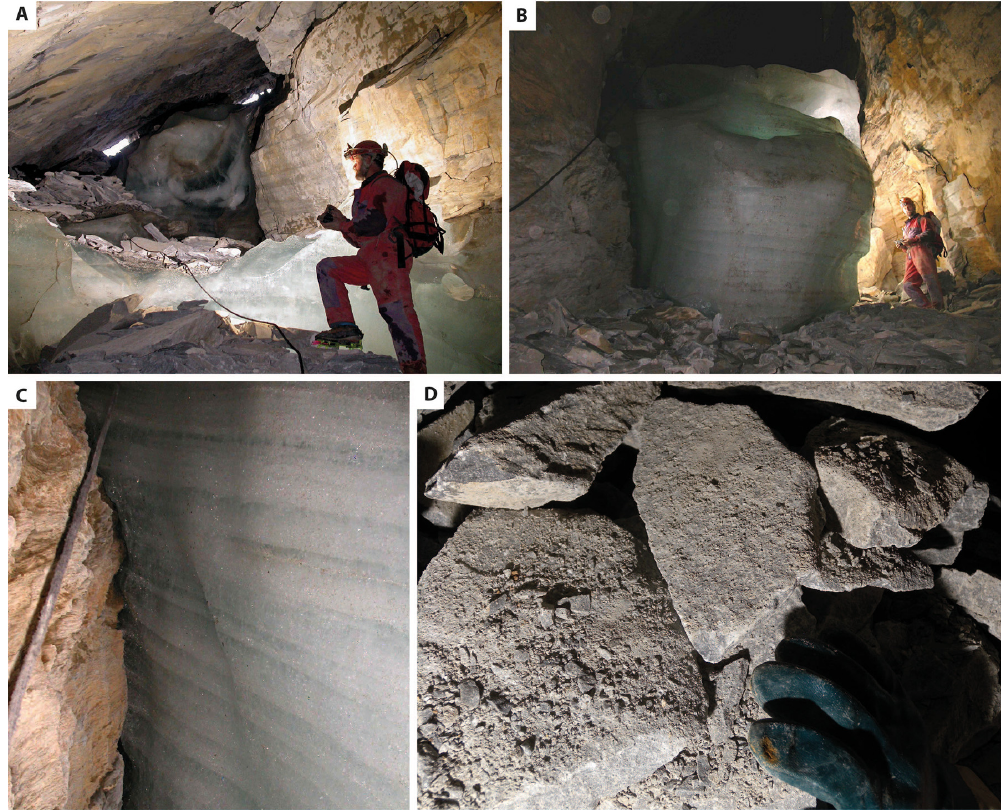
Figure 4. Ice and related features in MSK Cave. (a) View upwards towards the entrance which was partially ice-plugged in October 2005. (b) Lower end of the second ice body in October 2005. (c) Close-up of the ice cliff showing the banded ice stratigraphy. Height of image: 1m. (d) Melt-out till consisting of angular blocks and intermixed sand deposited since 2005; glove in the right-hand bottom corner for scale.